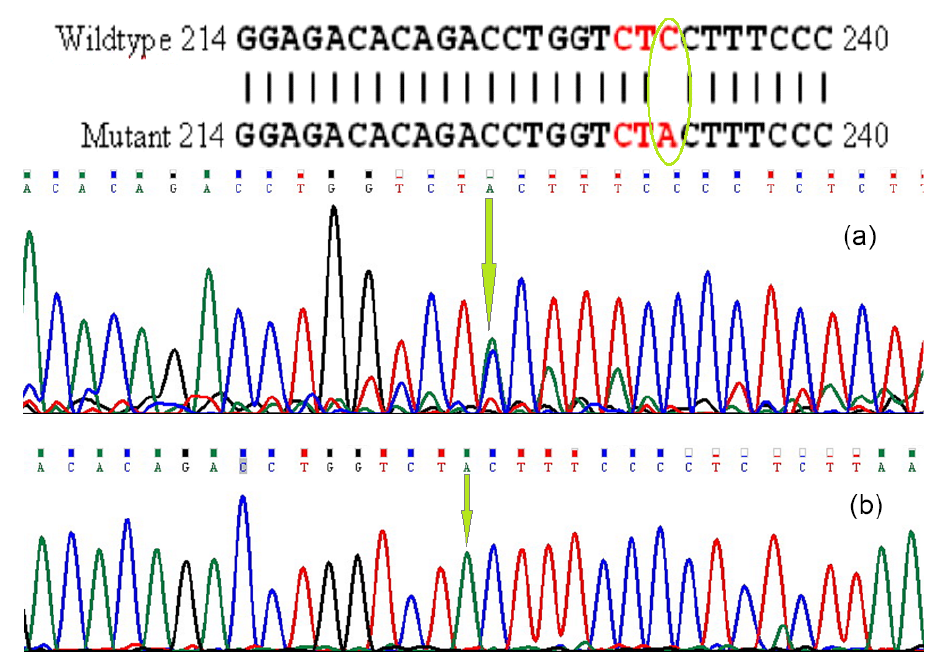
Figure 2. Nucleotide change in GDF9 (exon I): (a) heterozygote goat, (b) homozygote